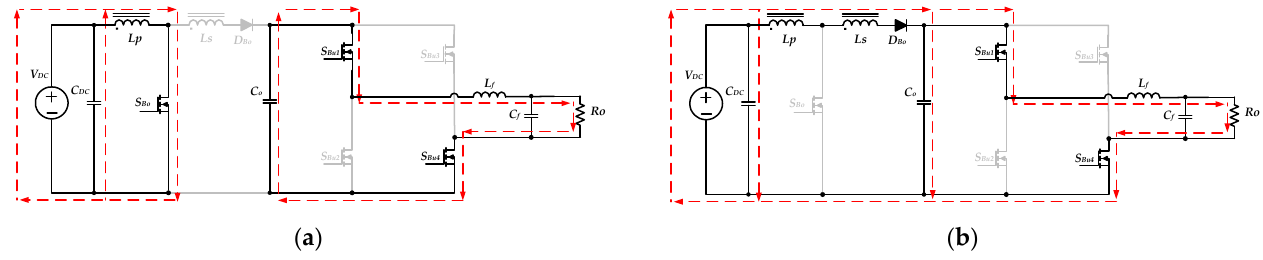
Figure 9. The equivalent circuits of the inverter operating in step-up mode during the positive half-cycle: ( a ) S Bo on; ( b ) S Bo off.